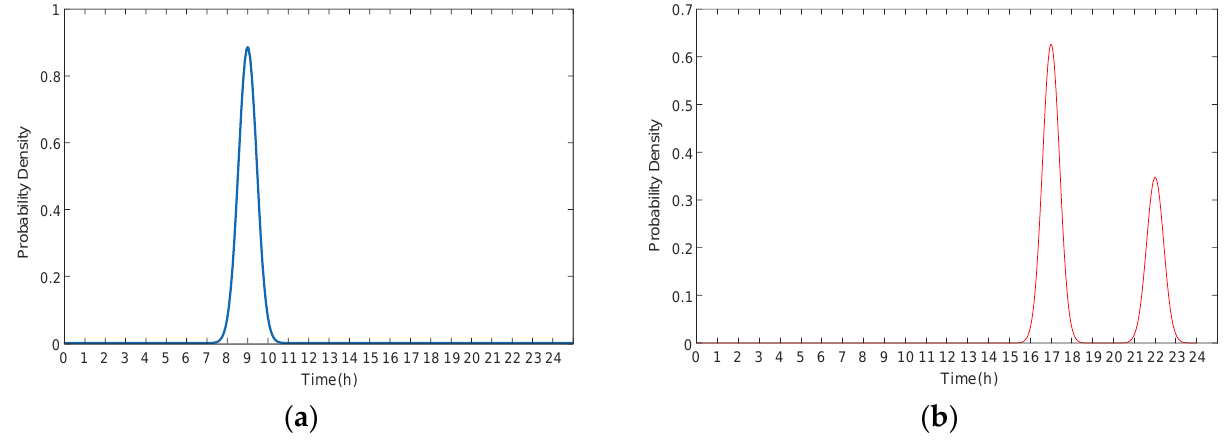
Figure 3. Probability density distribution of ( a ) arrival and ( b ) departure times of EVs. (1) Natural Gas and Electricity Purchased/Sold Results (1) Gas consumption and electricity purchased/sold before and after power consumption optimization are shown in Figure 4, where the electricity price unit is defined as CNY/kWh, which is the same as in other optimization figures. Before optimizing the commercial energy office building, natural gas is generated only by the consumption of heat generated by